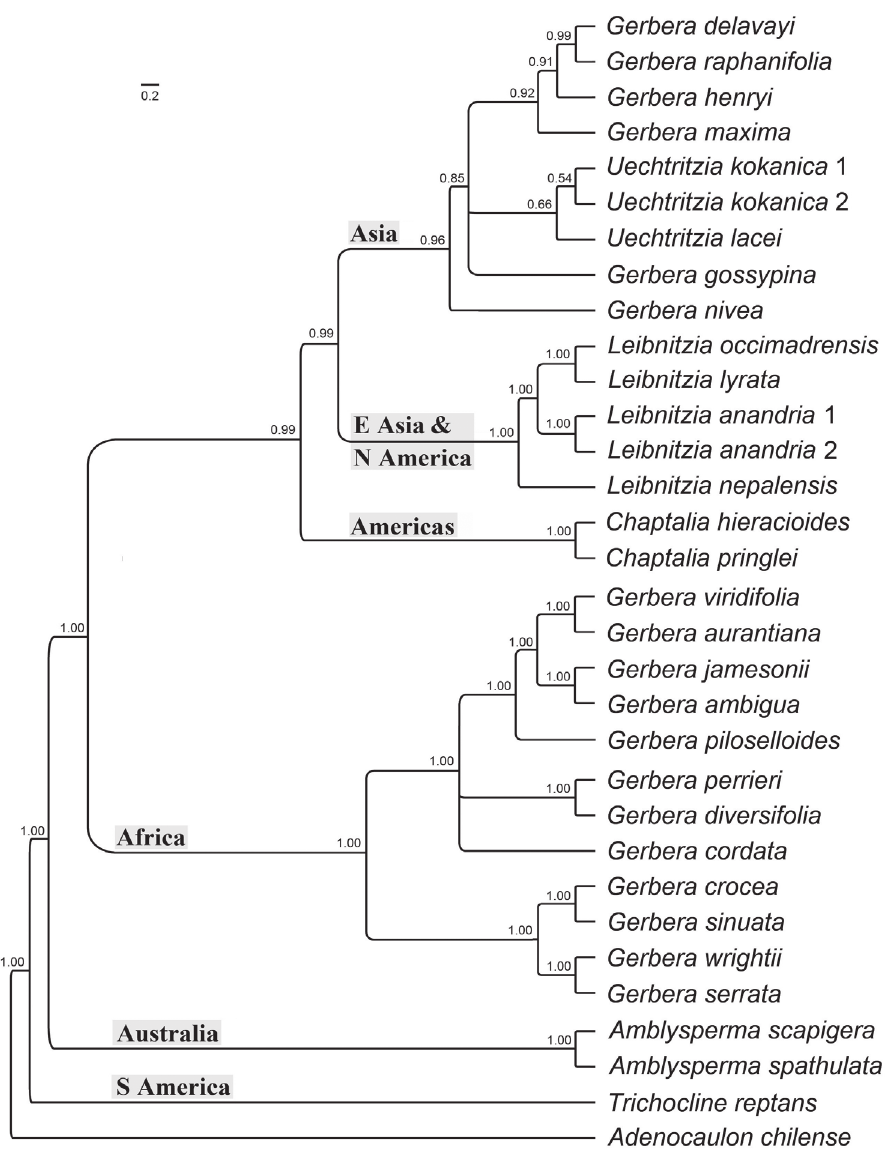
Figure 6. Phylogeny of the Gerbera -complex. The phylogeny is based on the Bayesian inference of the combined ITS and ETS, trn L– trn F, trn L– rpl 32 and trn C– pet N markers. The posterior probabilities are shown next to